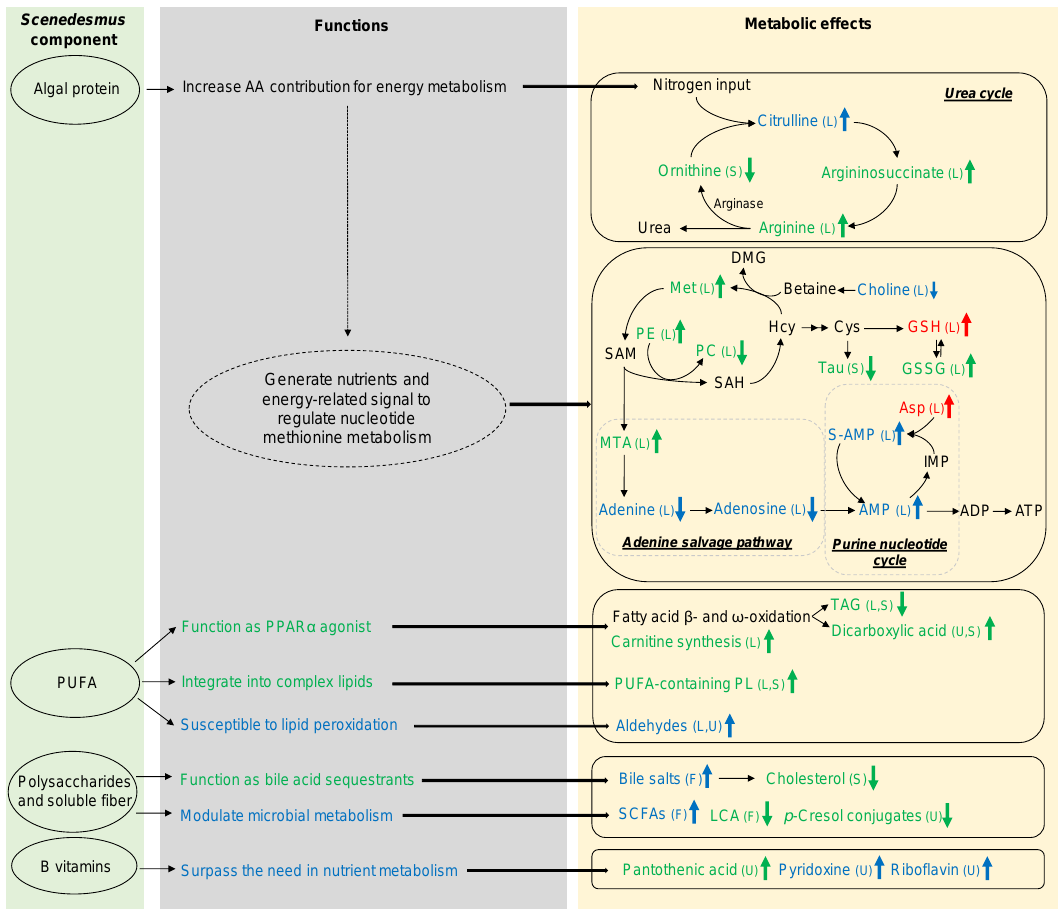
Figure 9. Summary on Scenedesmus -induced metabolic effects and its potential role in modulating metabolic system. Variety of components in Scenedesmus exert different functions in the body, which contribute to the metabolic changes after Scenedesmus feeding. Overall, Scenedesmus feeding targets multiple metabolic system, including urea cycle, purine metabolism, methionine metabolism, nuclear receptor PPARα metabolic pathway, redox balance, and microbial metabolism. Metabolic effects only induced by 5% are presented in red color, whereas 20% are in green color. Blue color indicate the metabolic effects induced by both 5% and 20% feeding. (AA, amino acid; Met, methionine; Hcy, homocysteine; Cys, cysteine; Tau, taurine; SAM, s-adenosylmethionine; SAH, s-adenosylhomocysteine; DMG, dimethylglycine; Asp, aspartic acid; ADP, adenosine diphosphate; ATP, adenosine